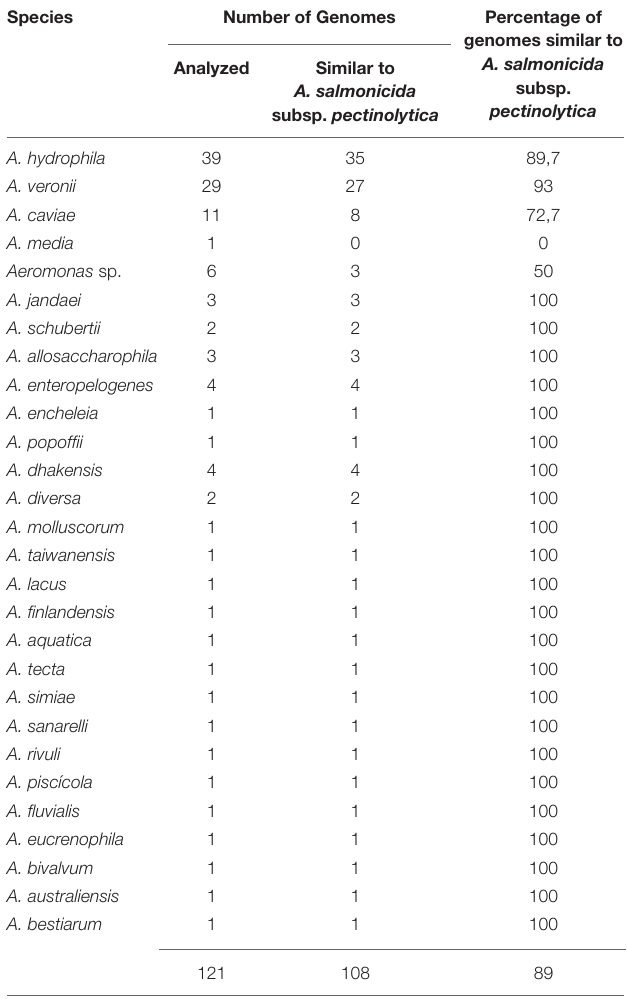
TABLE 4 | Genomic analyses of the A. salmonicida subsp. pectinolytica waa region 1 from strain 34melT versus the Aeromonas whole genomes from mesophilic